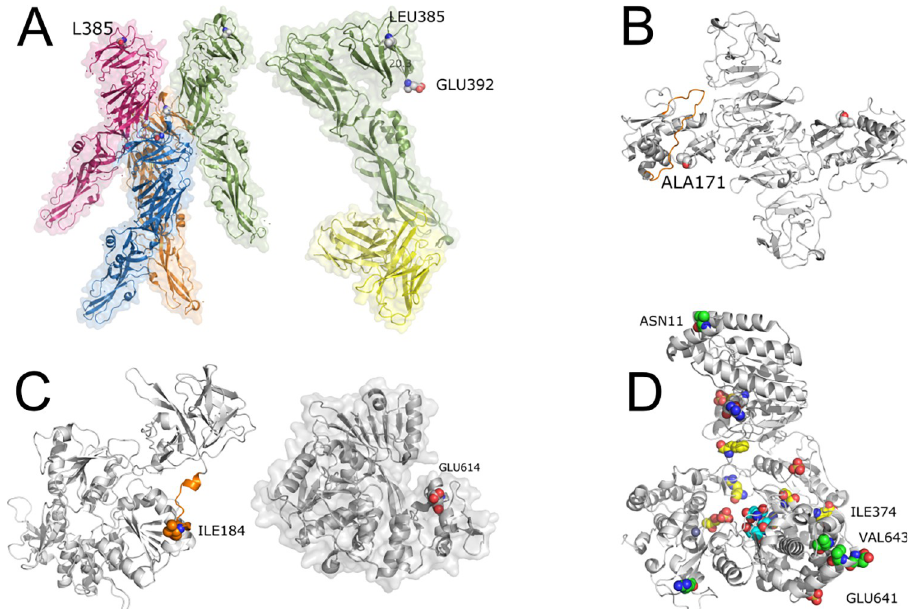
Fig 3. YFV proteins analysis. (A) Envelope protein—(A, left) PDB id 6wi5—tretamer of E protein LEU385 presented in spheres. (A, right) PDB id 6ivz—in green, one chain of protein E and in yellow, the light and heavy chains of monoclonal antibody 5A. Note that the L385F SNV is distant from both the binding between protein E chains and the antibody recognition site. (B) NS1 protein. Comparative model built with Swiss-Model and PDB id 5k6k. In orange, we depict the wing flexible loop and in spheres, SNV ALA171. (C) NS3 protein. (C, left) Comparative model built with Swiss-Model and PDB id 5yvu. In orange, we depict the interdomain linker region and in spheres, SNV ILE184. (C, right) GLU614 from PDB id 1yks showing that the SNV E614D is close to the cleft where the DNA binds the NS3 protein. (D) NS5 protein. In green, SNVs. In yellow, important conserved residues across ZIKV, DENV and WNV. In cyan, active site. In grey, ligand S-adenosyl-L-homocysteine. Sulfate and Zn ı´ons are also represented in spheres.